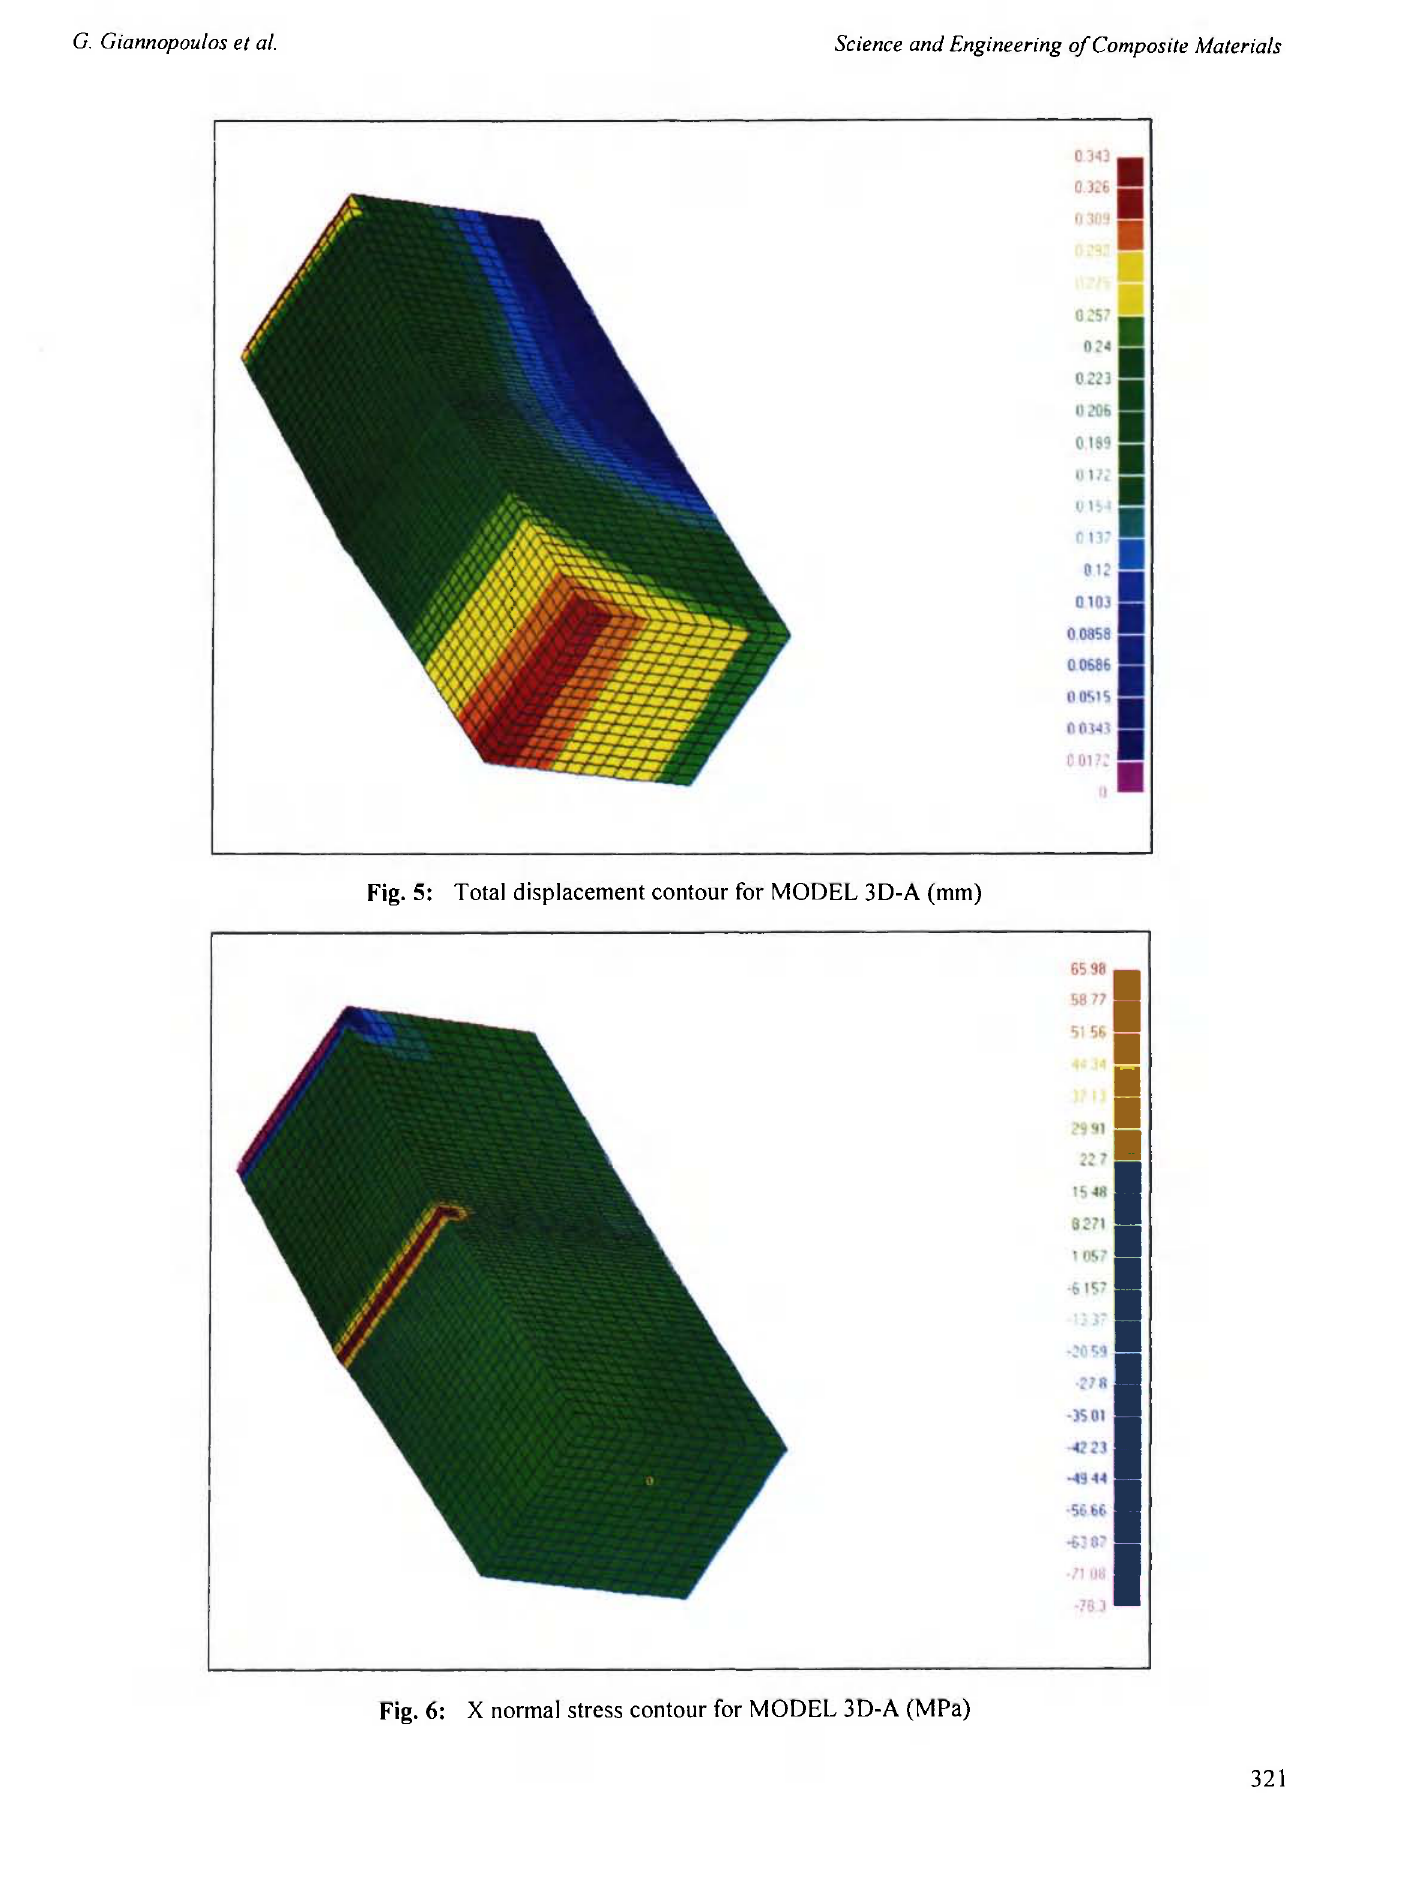
Fig. 5: Total displacement contour for MODEL 3D-A (mm)